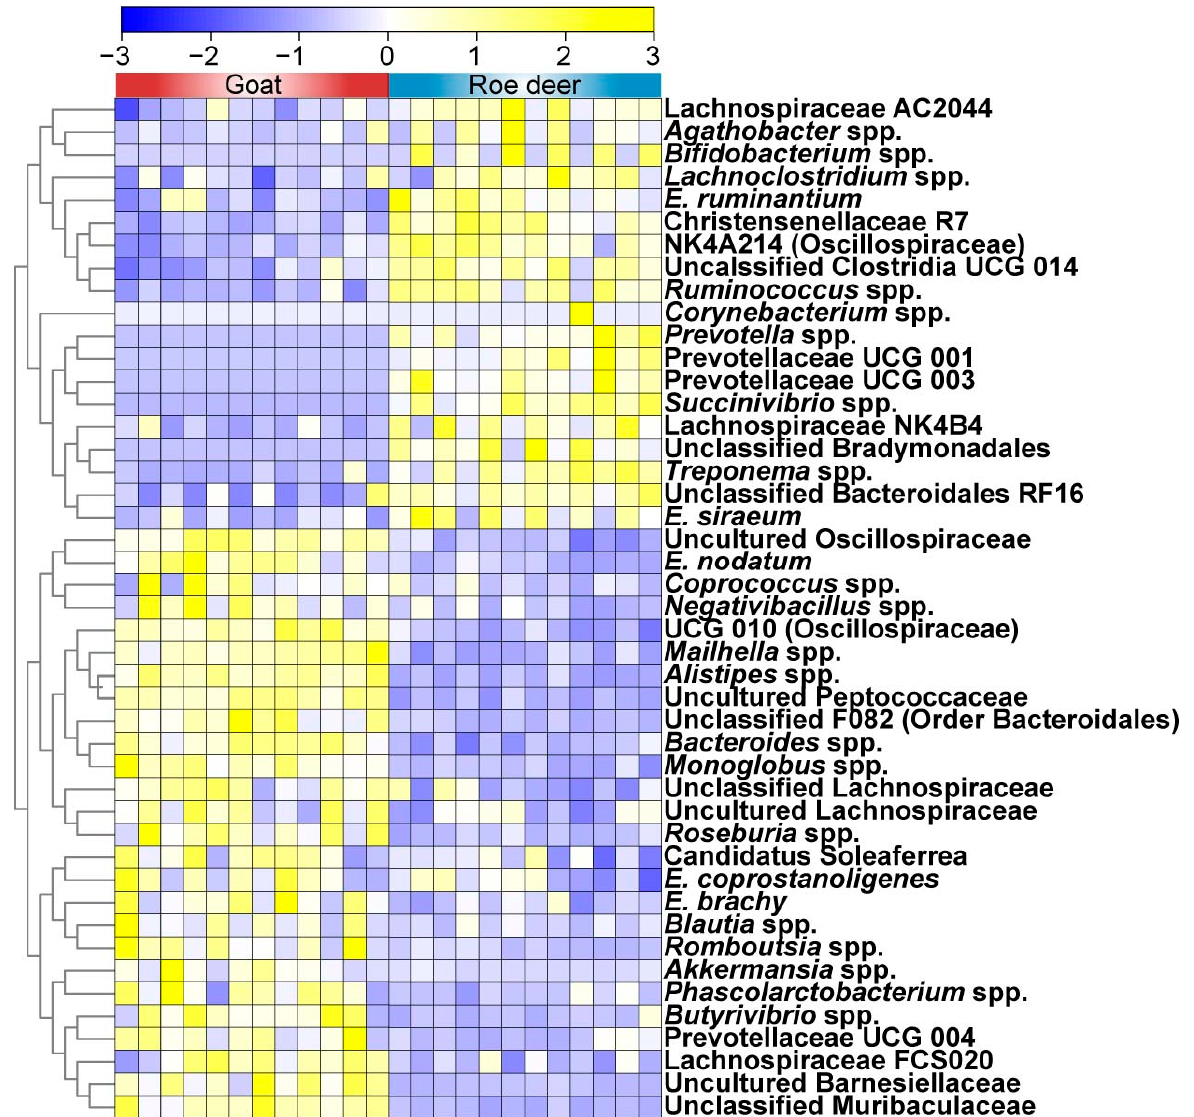
Figure 3. Heatmap showing the significantly changed bacteria in the feces of roe deer and goats at the genus level. Colors indicate the normalized relative abundance of each genus from minimum (blue) to maximum (yellow). The genera with relative abundances greater than 0.2% are presented in the heatmap. Samples from roe deer and goats are indicated by light blue and red bars at top of the heatmap.